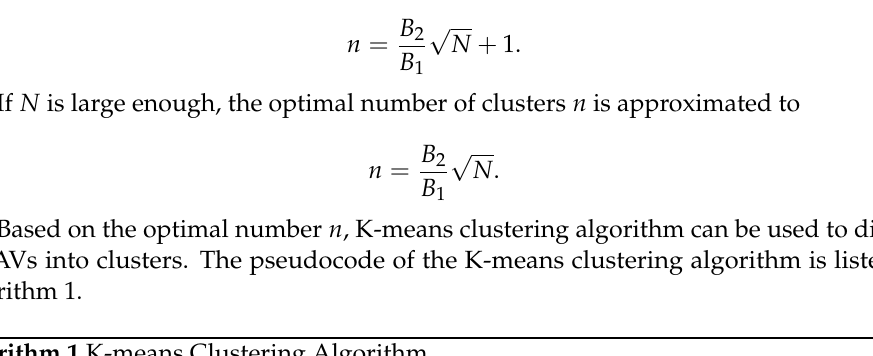
Algorithm 1 K-means Clustering